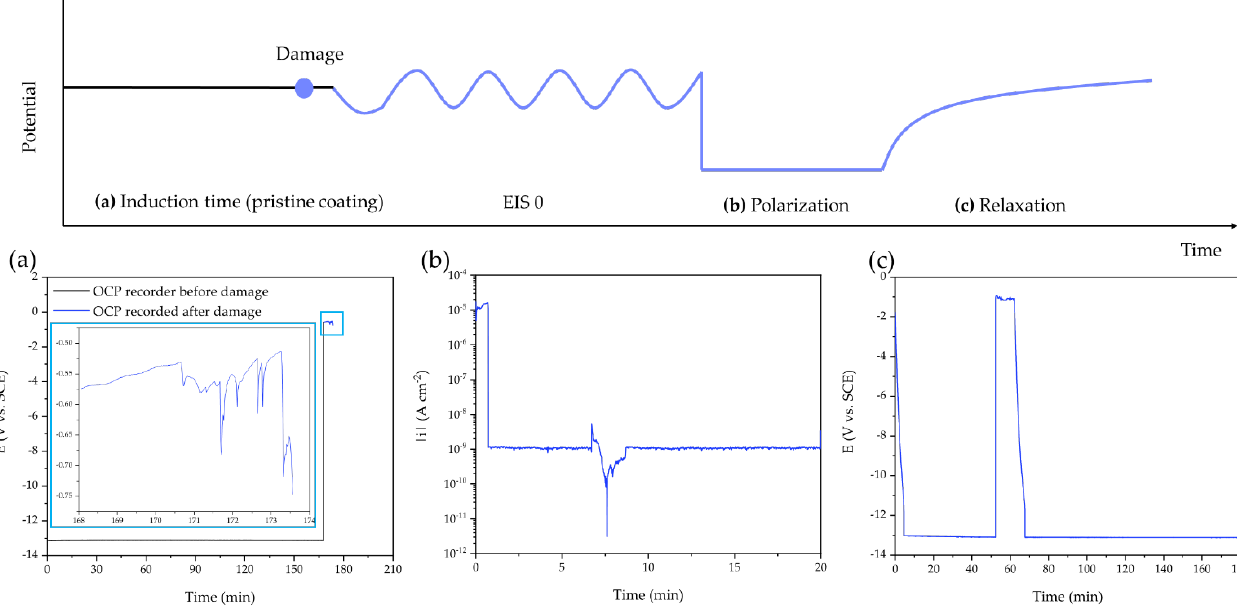
Figure 10. Evolution over time of some key electrochemical parameters (OCP ( a , c ) and current density ( b )) of a specimen with PPM copolymer coating before (black line) and after an artificial damage (blue line).